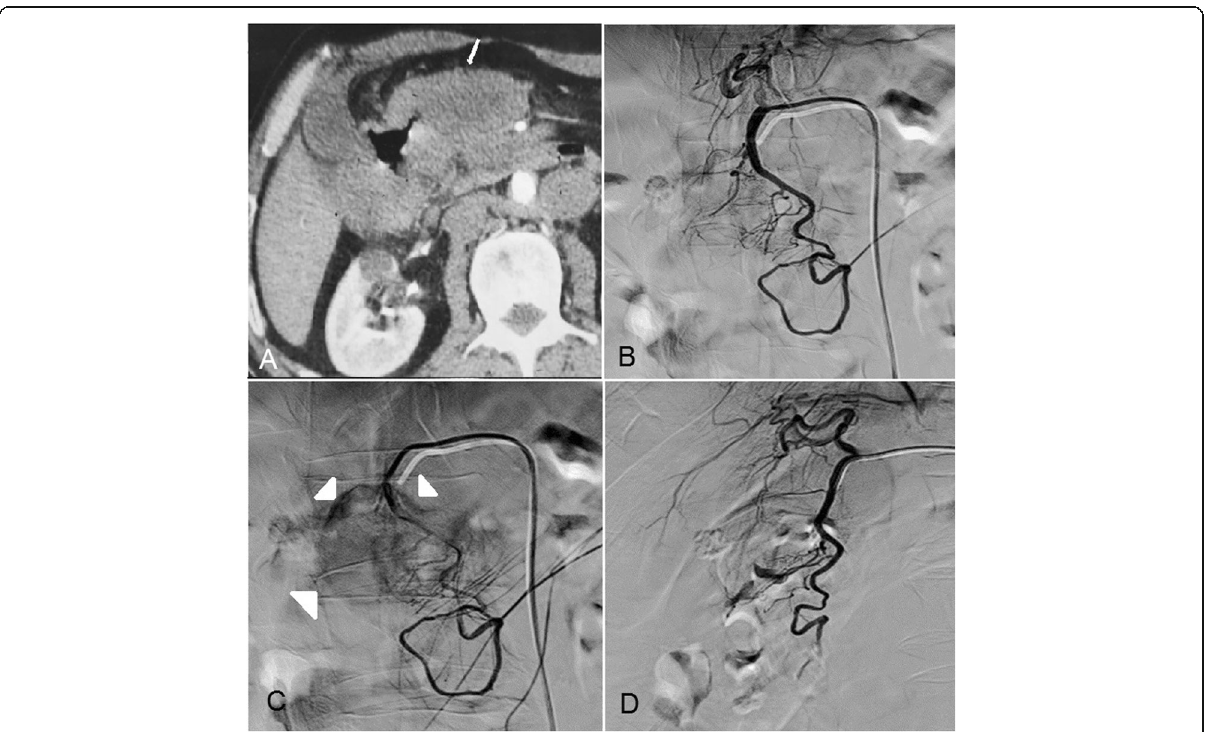
Fig. 3 a Axial CT scan for a patient with recurrent hepatic flexure mass infiltrating the duodenum (white arrow). b GDA angiogram shows the tumor neovascularity. c Delayed GDA angiogram shows the tumor blush (arrow heads). d Post-embolization angiograms demonstrate stasis with absent tumor blush